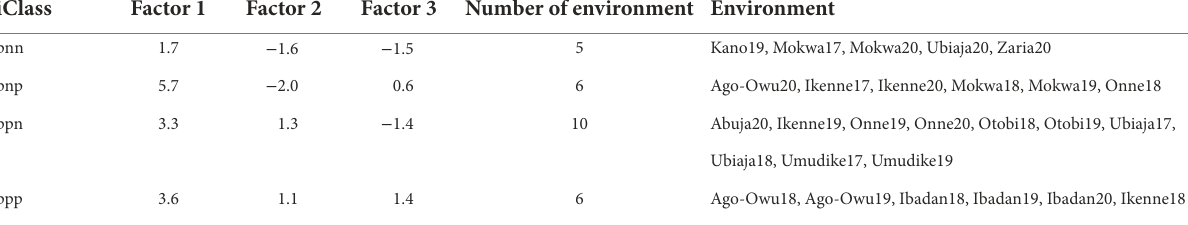
pnn, positive negative negative; pnp, positive negative positive; ppn, positive positive negative; and ppp, positive positive